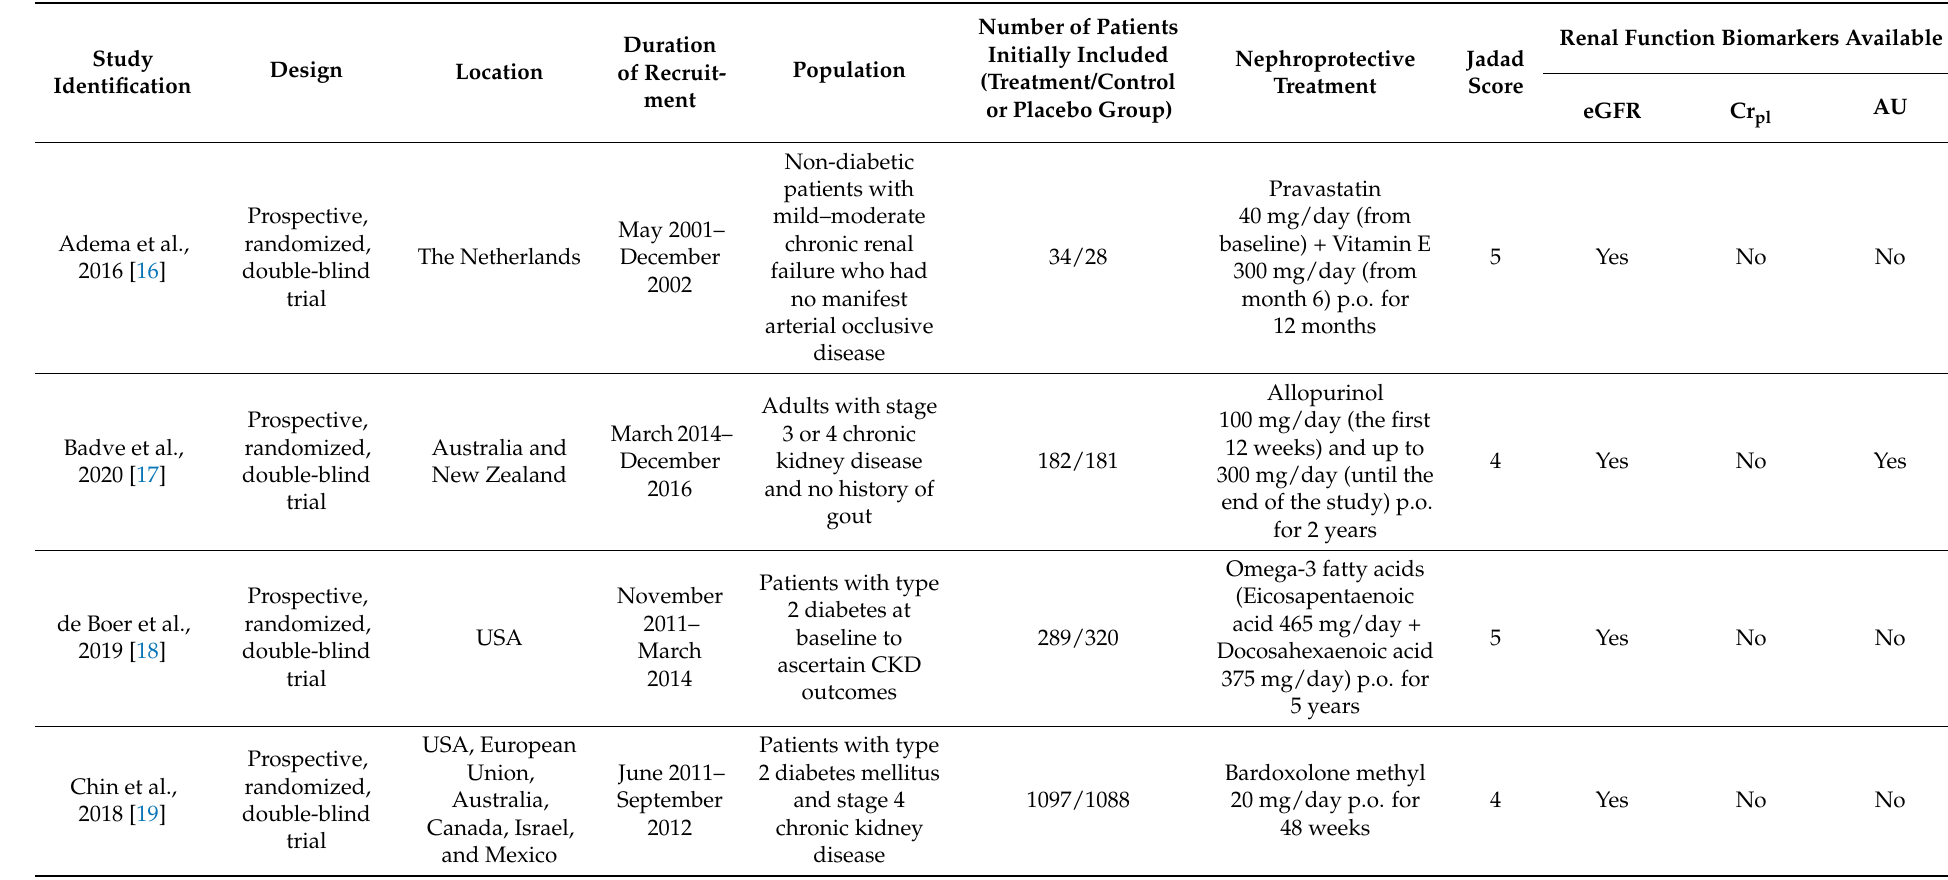
Table 1. Descriptive characteristics of the studies included in the meta-analysis. AU: albuminuria; Cr pl : plasma creatinine; eGFR: estimated glomerular filtration rate; p.o.: per os (oral